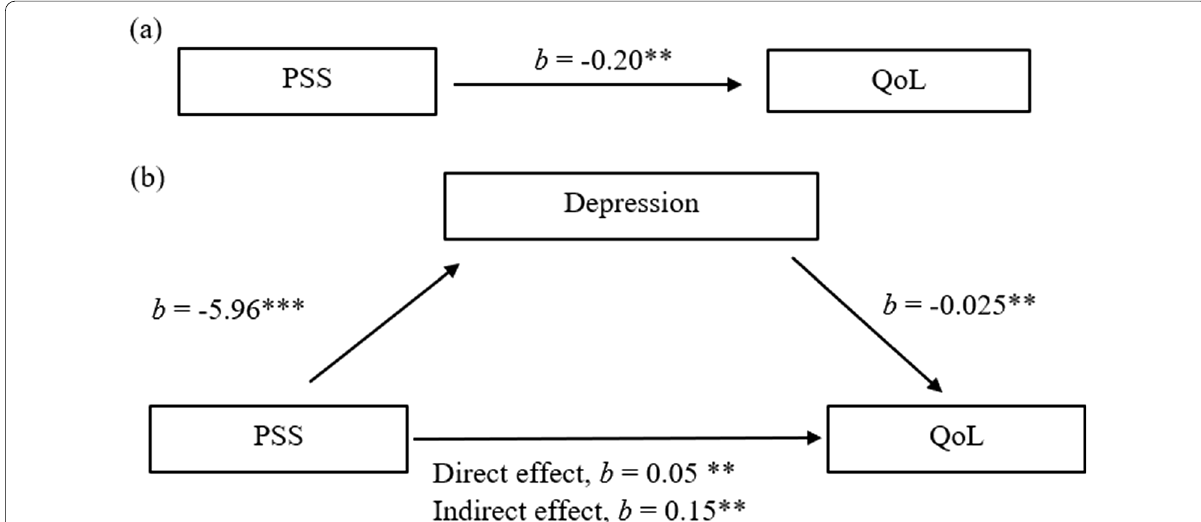
Fig. 1 Model of Perceived Social Support predicting Quality of Life, mediated by Depression with Non‑standardized estimates. The confidence interval for the indirect effect is a BCa bootstrapped CI based on 5000 samples. ** p < 0.001